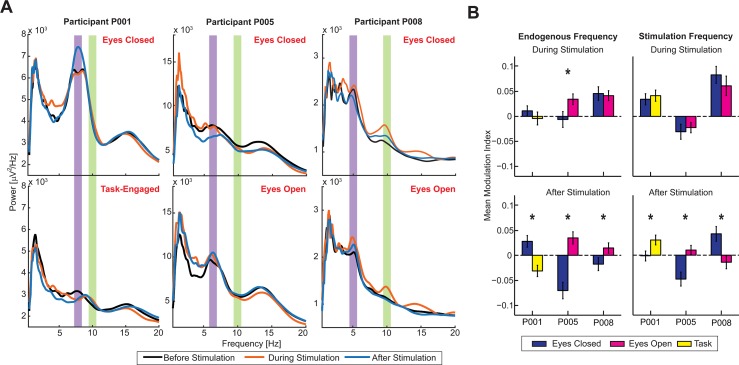
State-Dependent Modulation by Periodic Stimulation.(A) Power spectra in the epochs before stimulation (black trace), during stimulation (orange trace), and after stimulation (blue trace) for the three participants during the different states. Participant P001’s spectra showed no appreciable change in the eyes-closed state in the endogenous frequency band (violet shaded region) and minimal change in the stimulation frequency band (green shaded region) in eyes-closed state during stimulation. However, there was a change in dominant oscillation frequency from endogenous frequency to stimulation frequency in the task-engaged state. P005 showed no change in power at endogenous frequency in the eyes-closed state, while there was an increase in the eyes-open state. Power at stimulation frequency was decreased in both states. P008 showed an increase in both states in the endogenous and stimulation frequencies. (B) Mean modulation indices at the endogenous frequency (left) and the stimulation frequency (right) in the epochs during stimulation (top) and after stimulation (bottom) for each of the three participants. Bars denote standard error of mean. * denotes statistical significance (p < 0.05) from a paired t test. The data shown in this figure are available online: http://dx.doi.org/10.5281/zenodo.45811